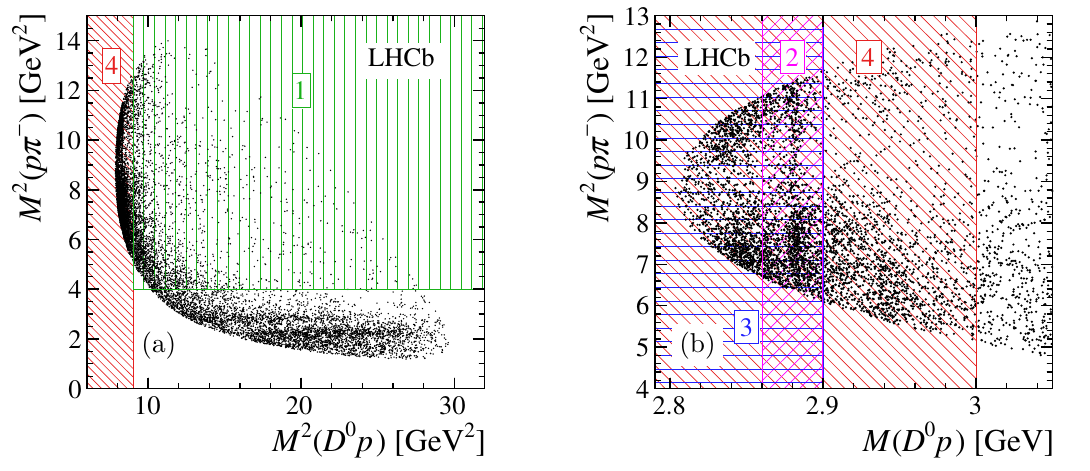
Figure 3 . Distributions of (cid:3) 0 ! D 0 p(cid:25) (cid:0) candidates in data: (a) the full Dalitz plot as a function b of M 2 ( D 0 p ) and M 2 ( p(cid:25) (cid:0) ), and (b) the part of the phase space including the resonances in